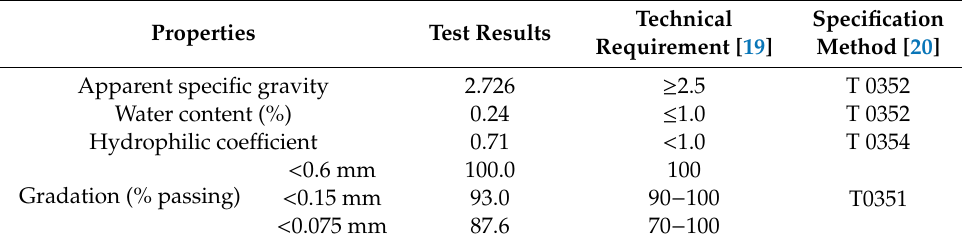
Table 3. Properties of mineral filler.